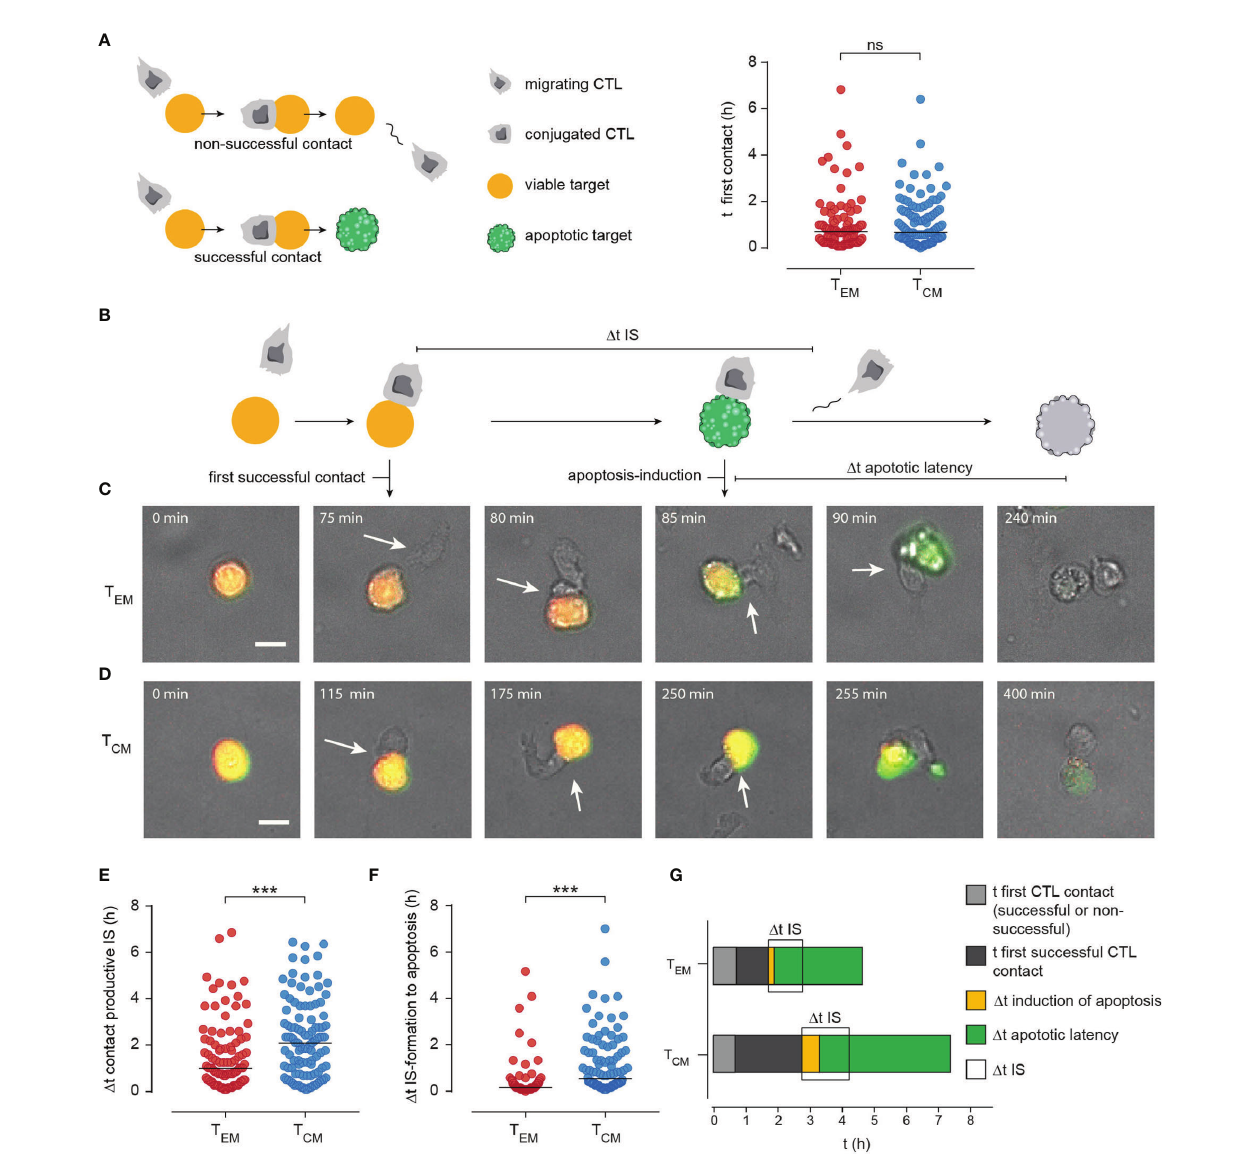
FIGURE 7 | Manual tracking CTL-target cell contacts/interaction uncovers enhanced ef fi ciency of immune synapse (IS) formation in T EM . (A) Scheme of CTL-target cell interaction: When a CTL approaches a target cell this can result in a non-productive (no induction of apoptosis or necrosis, CTL leaves the viable target after minutes – hours) or in a productive contact that results in apoptosis or necrosis of the target cell. To check if differences in target cell lysis ef fi ciency of T EM and T CM are dependent on migration the time point of the fi rst contact (whether non-productive or productive) was compared. (B) Scheme to illustrate the kinetics of productive CTL-target cell interaction: t of fi rst productive contact ( D t of duration from start of the measurement until formation of a productive/lytic synapse. Time point of apoptosis induction ( fi rst signs of caspase activity detected by green fl uorescence. D t apoptotic latency: from induction of apoptosis until necrotic lysis of the cell (duration a cell was apoptotic). (C, D) Representative images of T EM (C) or T CM (D) mediated target cell lysis. Scale bars are 10 µm. (E) Single-cell data of time point of productive IS formation. (F) Single- cell data of D t of apoptosis induction (from IS-formation to fi rst signs of caspase activity). (G) Stacked bar graphs to summarize manually tracked single cell data from T EM and T CM mediated target cell lysis. t of fi rst contact successful or non- successful (light grey). t of formation of the fi rst productive contact (dark grey), D t of apoptosis- induction (yellow), D t of apoptotic latency (green). D t IS: Duration of an IS between T EM or T CM and a target cell is shown in light grey. Durations of the phases are show as median. n=4 donors, T EM 94 cells, T CM 100 cells. ***p<0.001; ns, no signi fi cant